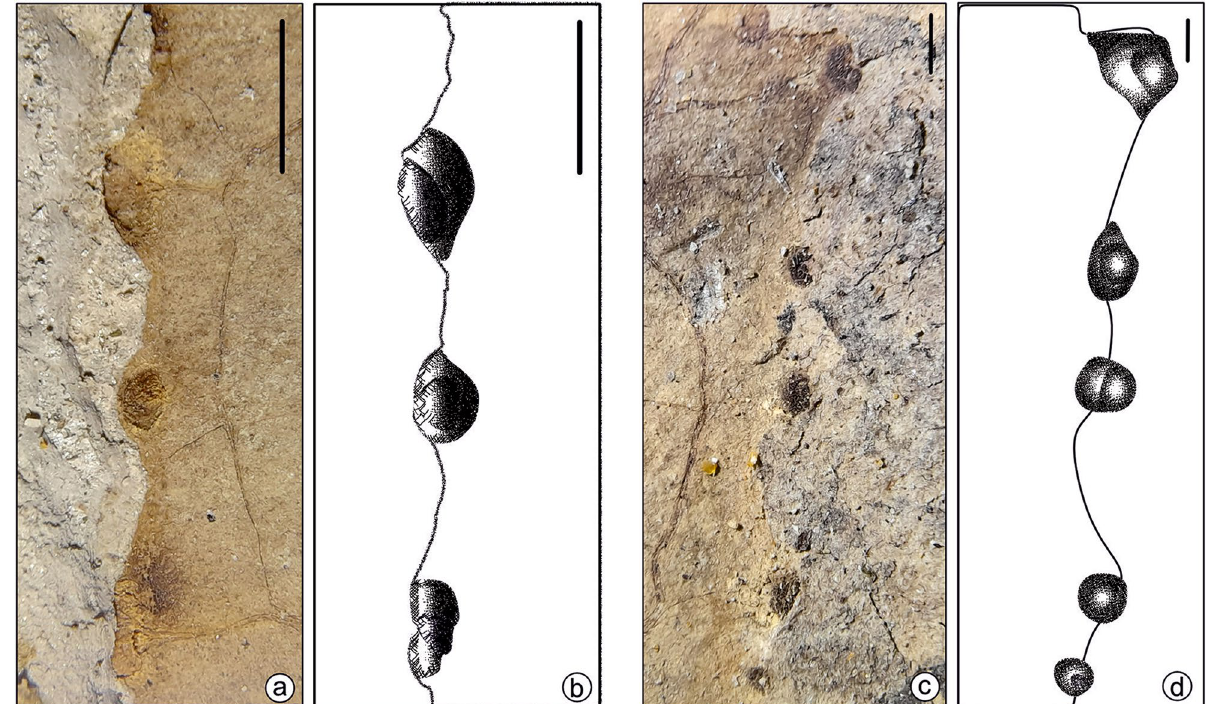
Figure 4. Enlargement and line drawings of marginal galls. Specimen SKBUH/PPL/JH/325C ( a,b ); specimen SKBUH/PPL/JH/324A ( c,d ). Scale bar = 1